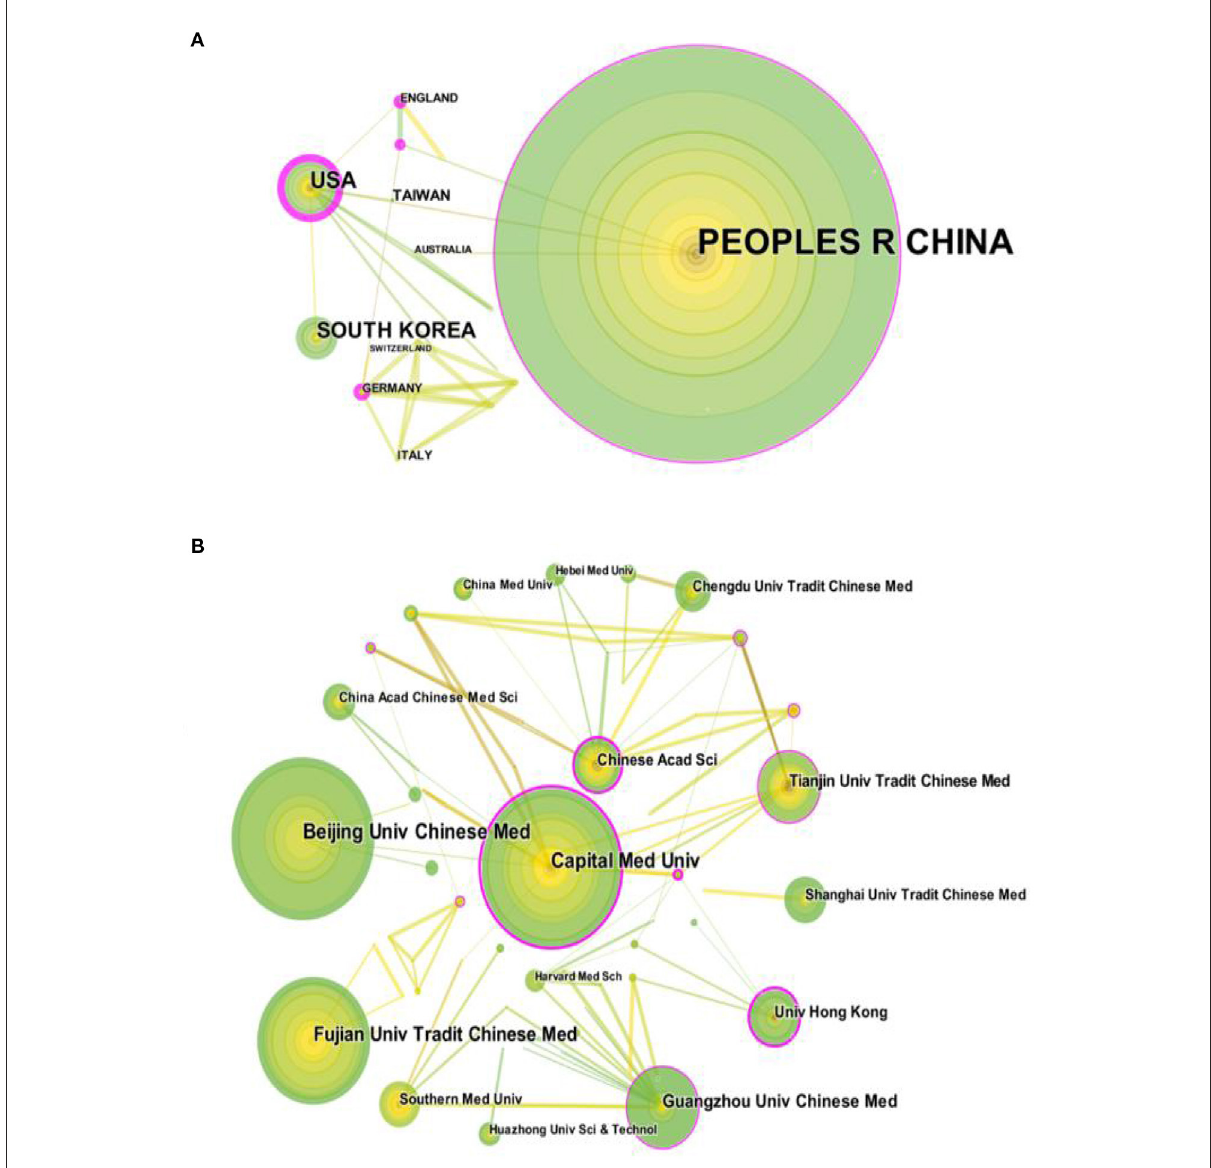
FIGURE3 Cooperative network of countries/regions and institutions that publish relevantly literature (A) Co-authoring network map among countries/ regions acupuncture treats cognitive impairment. (B) Network map co-authored between institutions. In a network map, a dot represents a country/institution, and a line between 2 dots represents a partnership, a wider line indicates a stronger